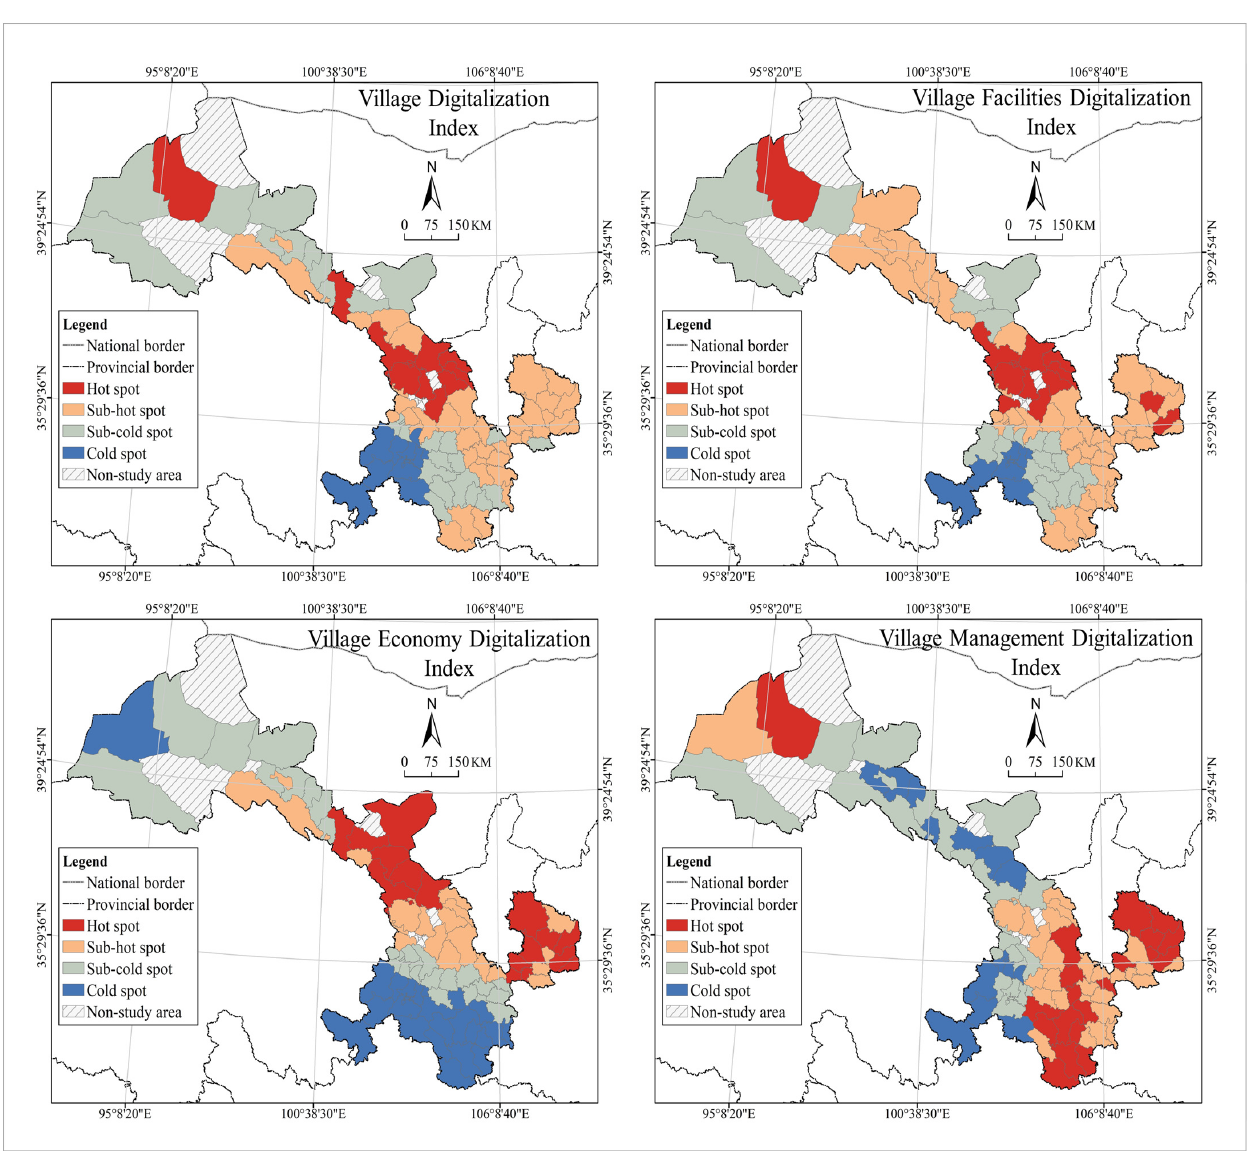
Figure 7. Analysis on spatial effect of village digitalization in Gansu.